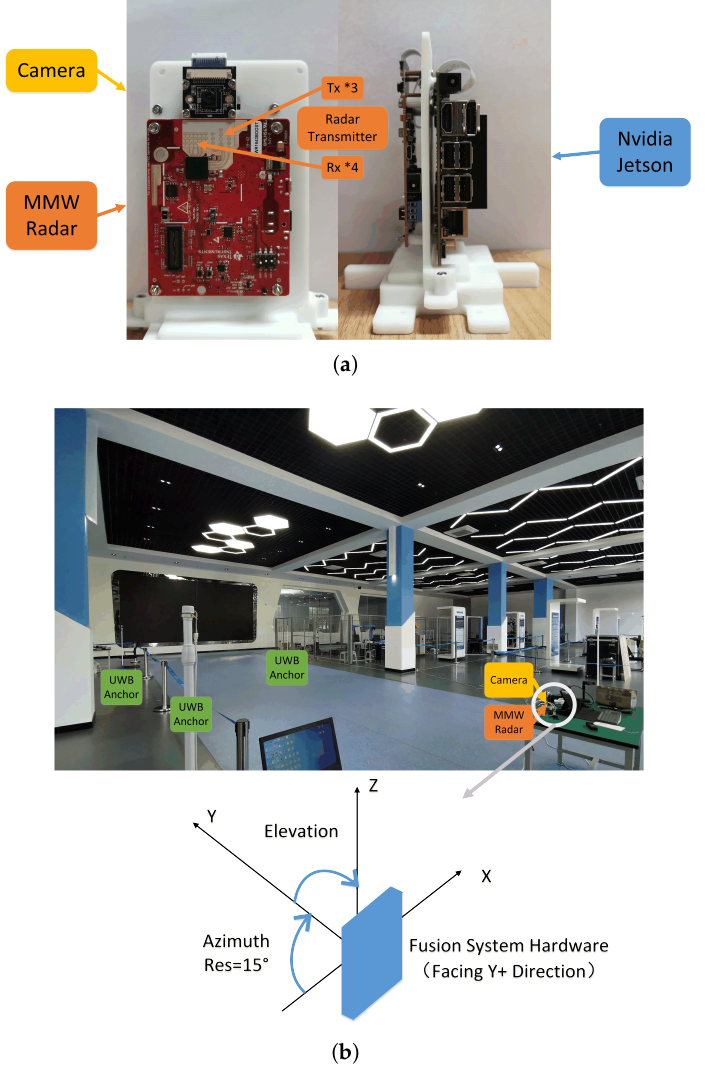
Figure 4. The test setup with camera, MMW radar and UWB system. ( a ) Fusion system layout. ( b ) UWB system layout and the test